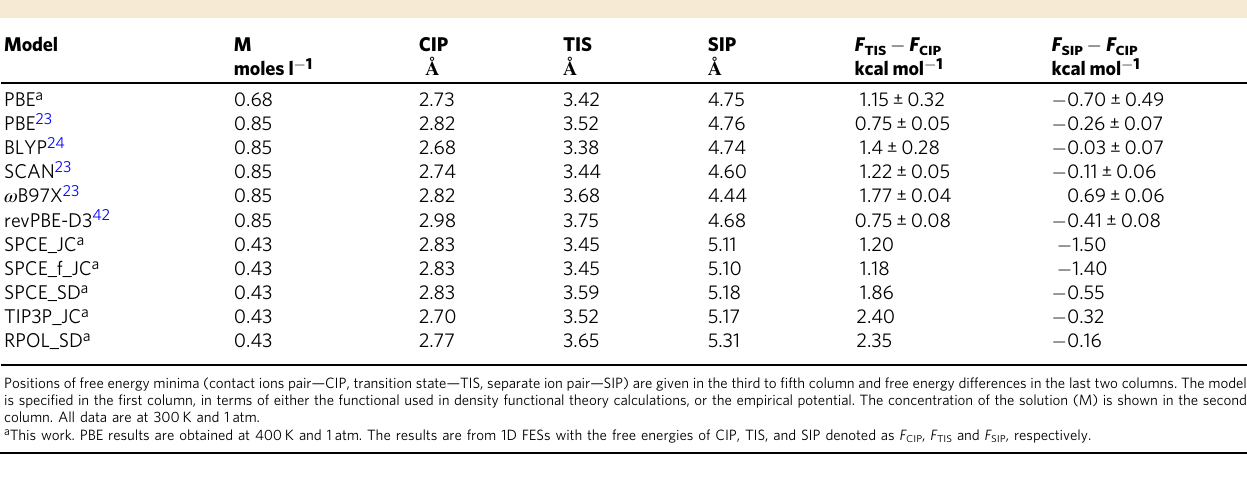
Table 1 Free energy properties.